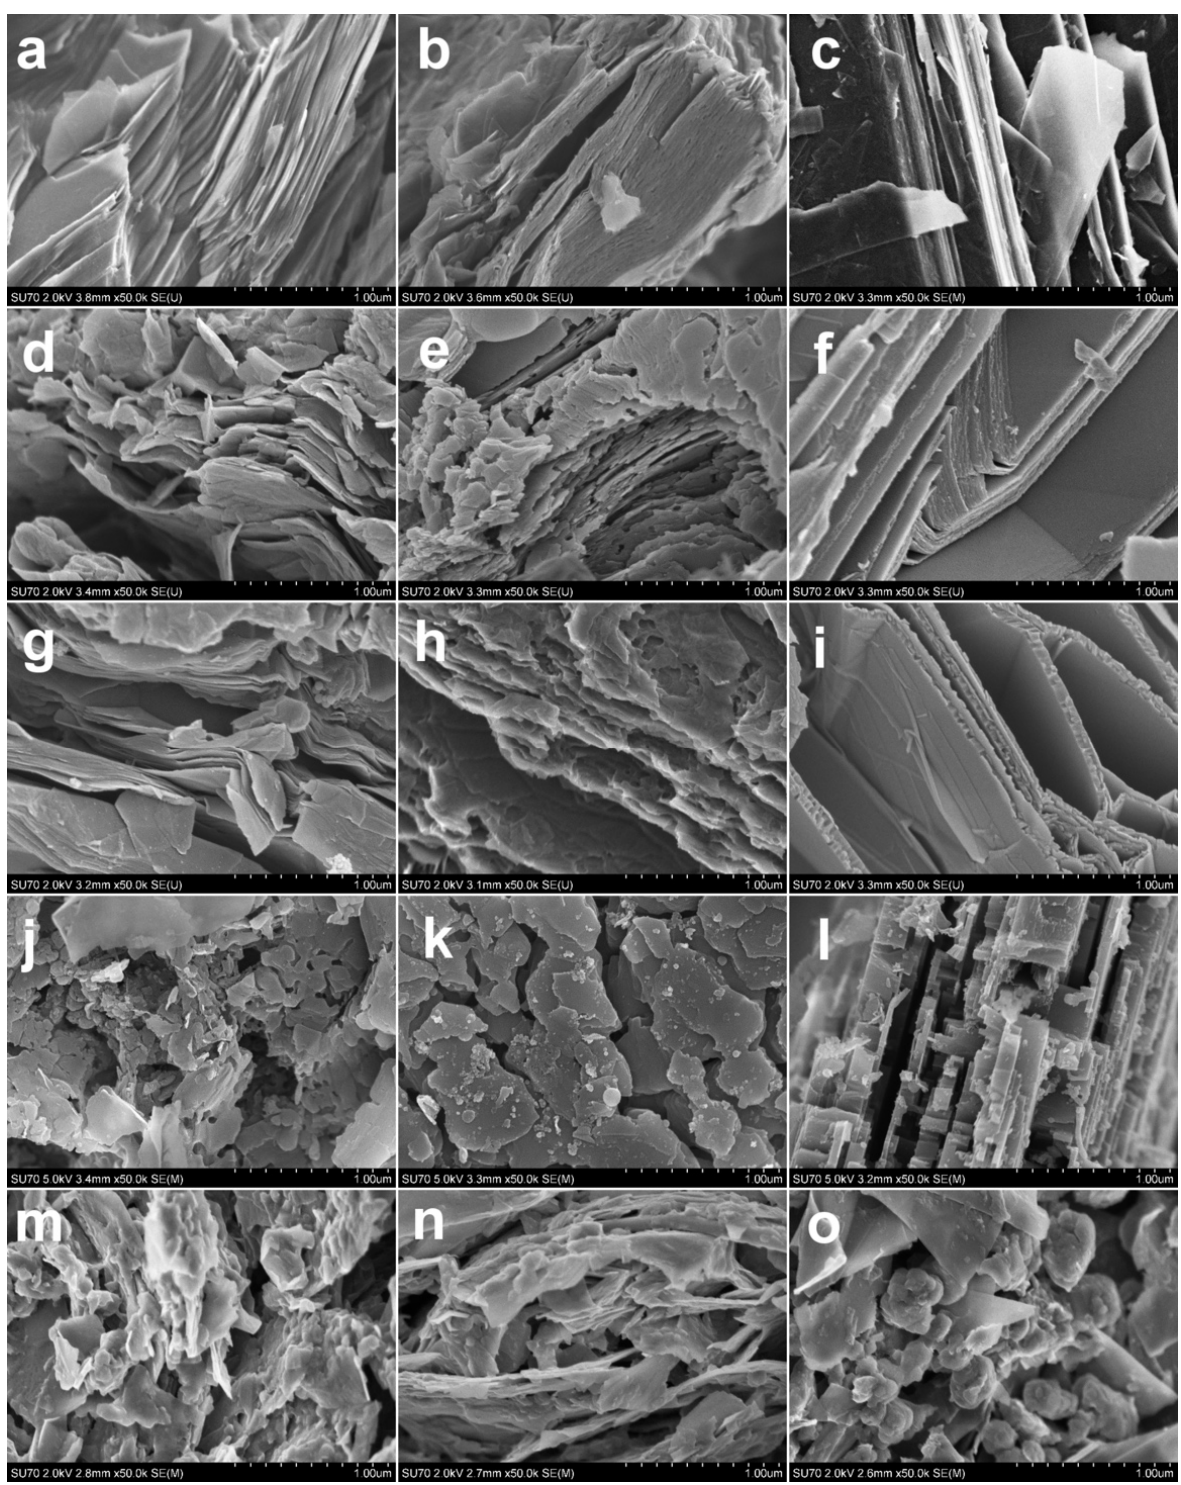
Figure 2. SEM micrographs of precursor graphite of different grain sizes, EG and GP